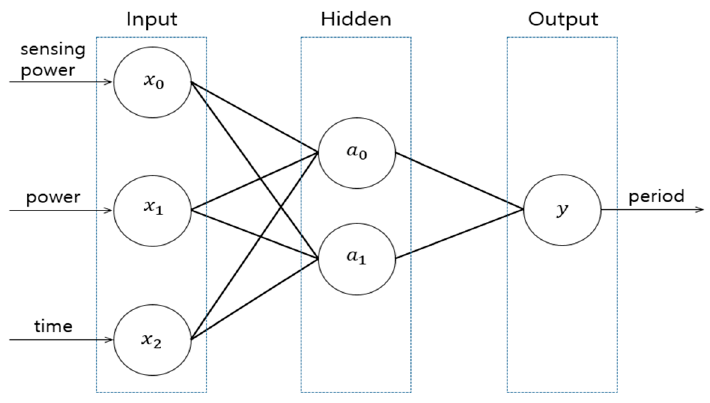
Figure 4. BPNN for smart sensing structures.